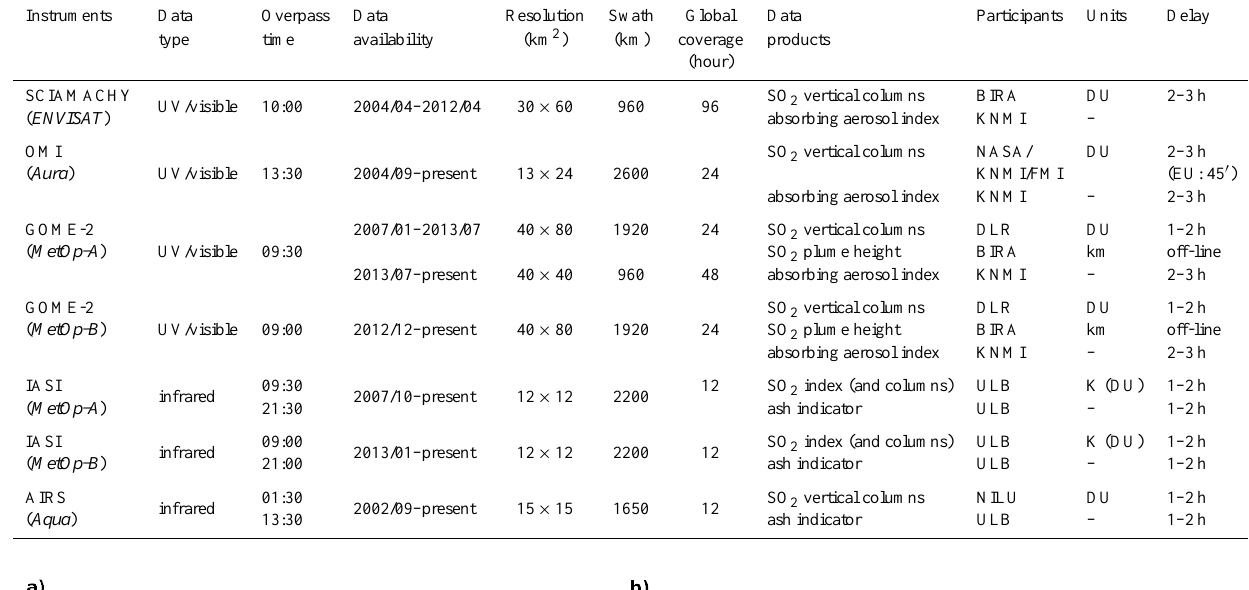
Table 1. List of data products available from SACS.